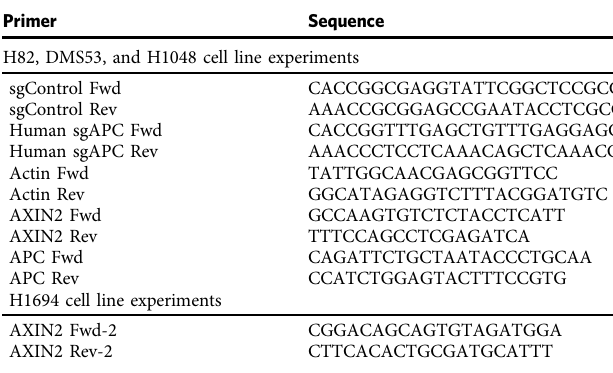
(Supplementary table 7) after analyzing WNT gene lists R-HSA195721 (Signaling by WNT) and R-HSA-3858494 ( β -catenin independent WNT signaling). Transcriptome alignment and expression estimation . Fasta fi les were trimmed using Flexbar 56 with settings: -adapter-min-overlap 7 -min-read-length 20 to improve read alignments. Reads were aligned by hisat2.0.5 57 using Ensembl version 74 transcripts. Reads were sorted and indexed by SAMtools 1.3.1 58 and then used for expression estimation by Stringtie 1.3.3 59